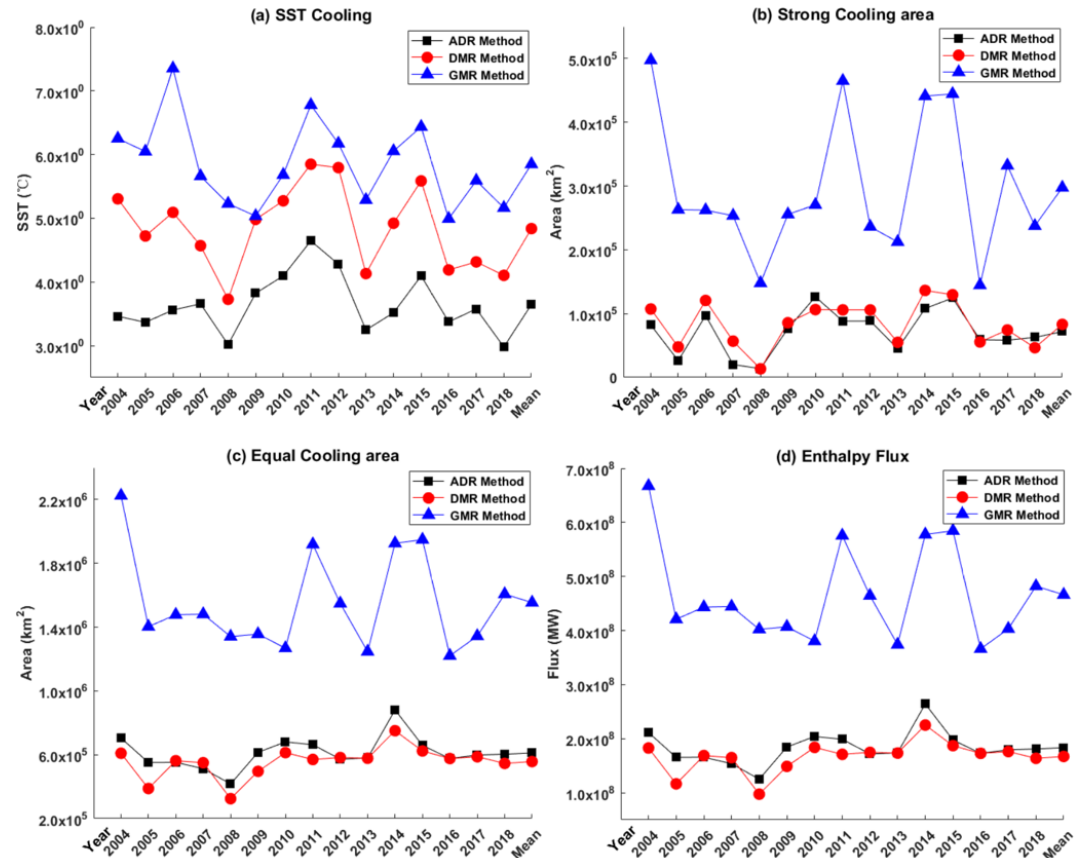
Figure 5. Results calculated by the ADR, DMR and GMR methods for 2004–2018: ( a ) average typhoon-induced SST cooling; ( b ) average typhoon-induced area of strong SST cooling; ( c ) average typhoon-induced area of 3 °C SST cooling; and ( d ) average typhoon-induced heat flux anomalies.